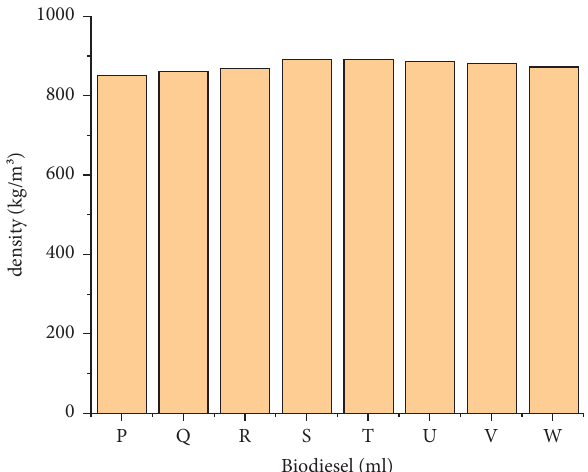
Figure 2: Te trend of decreasing calorifc values of